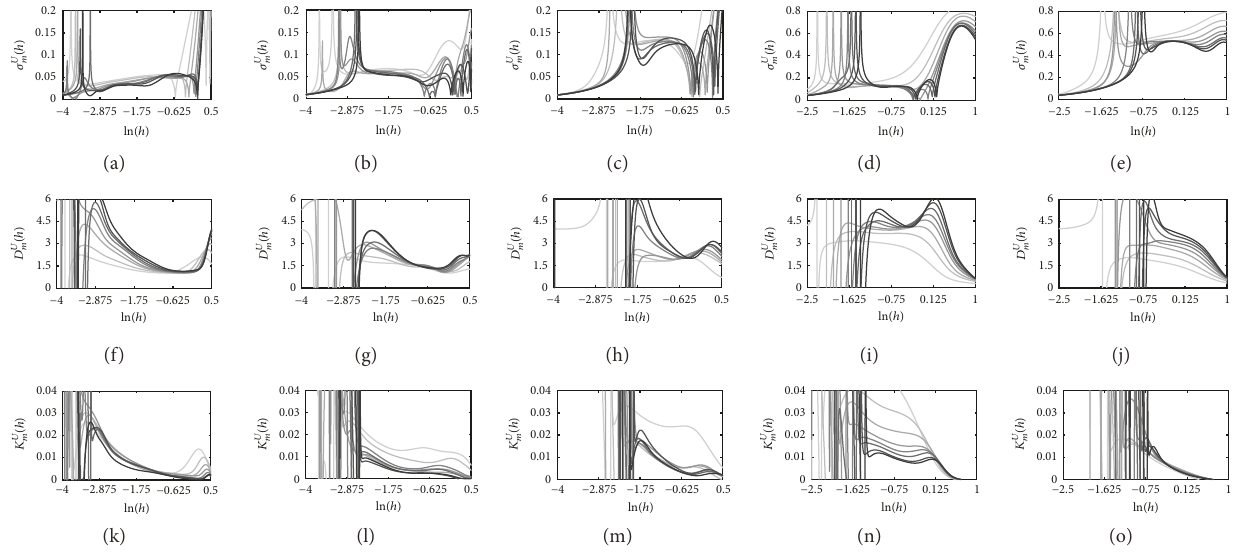
Figure 2: Coarse-grained estimators 𝜎 𝑈 𝑚 (ℎ) , 𝐷 𝑈 𝑚 (ℎ) , and 𝐾 𝑈 𝑚 (ℎ) for normal and pathological voices. First column: normal voice; second column:pathologicaltype 1 voice;thirdcolumn:pathologicaltype 2 voice;fourthcolumn:pathologicaltype 3